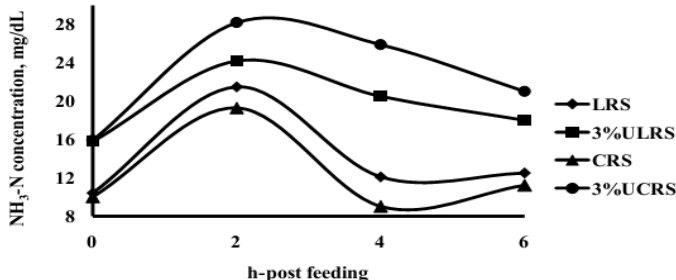
Figure 2. Effect of physical form and urea treatment of rice straw on rumen NH 3 -N concentration at 0, 2, 4, and 6 h-post feeding in dairy steers.